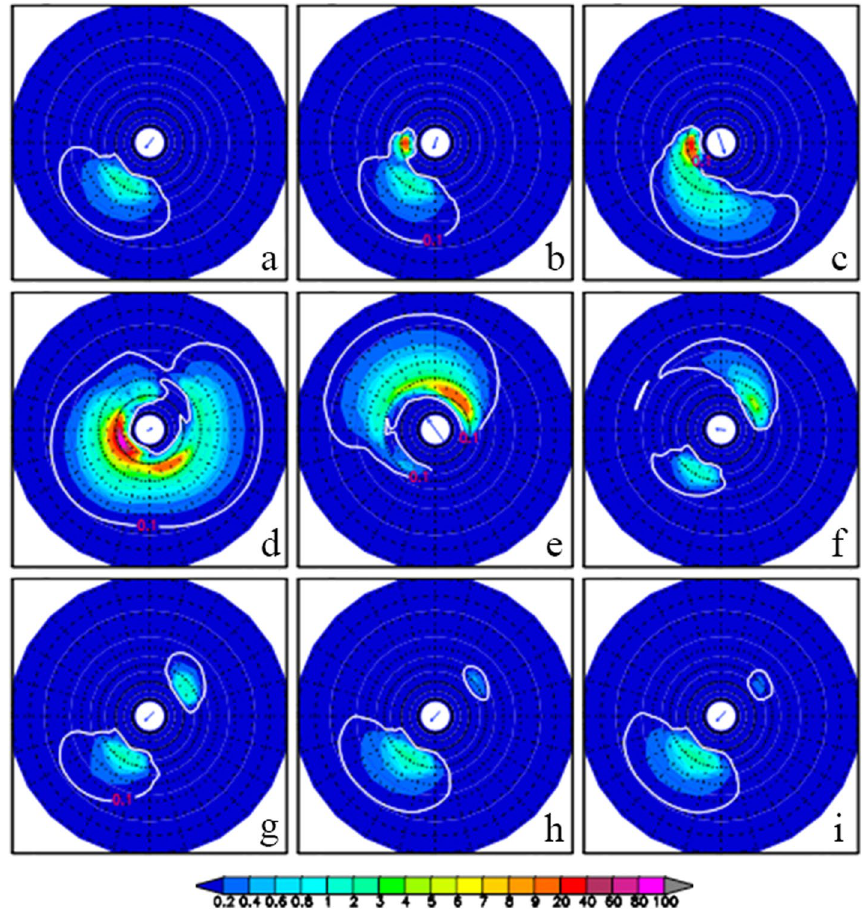
Figure 6. Numerical experiment with NE monsoon winds: 12-h evolution of directional wave spectra at the reference point (114.0° E, 13.8° N) from 1200UTC December 1 to 1200UTC December 5,